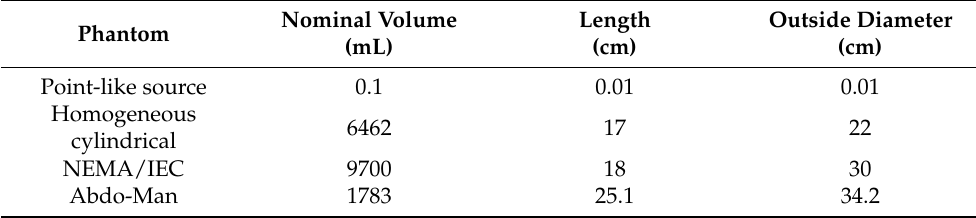
Table 1. The main geometrical characteristics of the investigated phantoms/geometries.